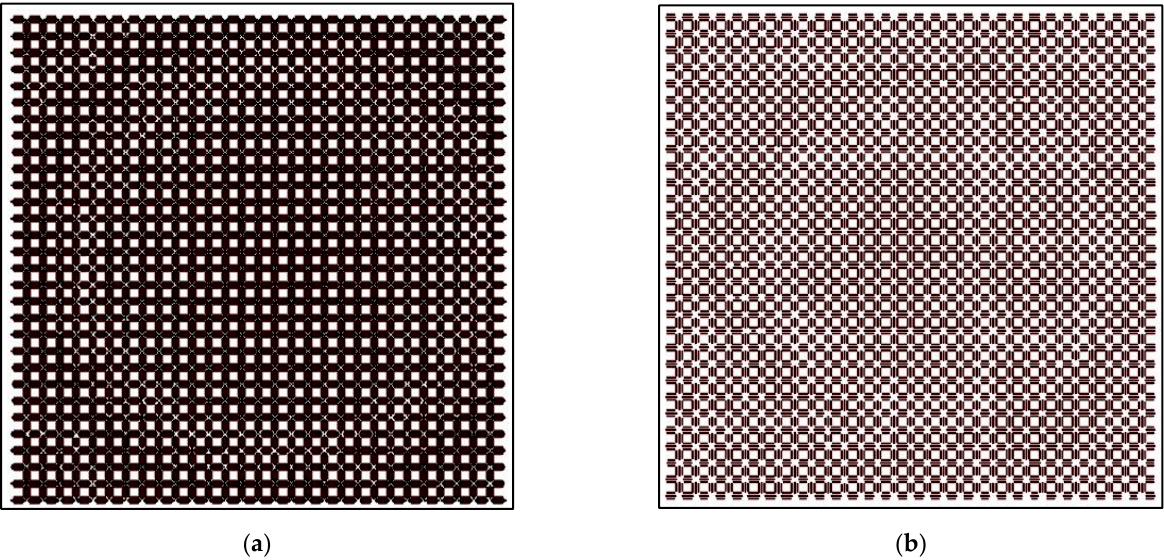
Figure 15. Photo-etching masks for the ( a ) lower layer and ( b ) upper layer of dipoles. dual-band polarizer reflectarray at 19.7 GHz and 29.5 GHz (center frequencies). To